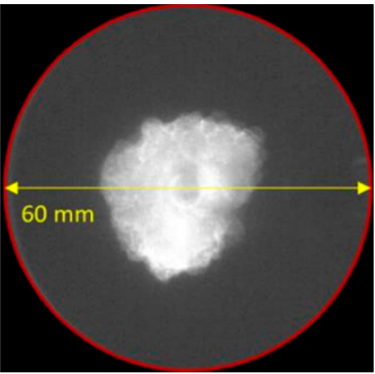
Figure 3. Detection of the fl ame front evolution.